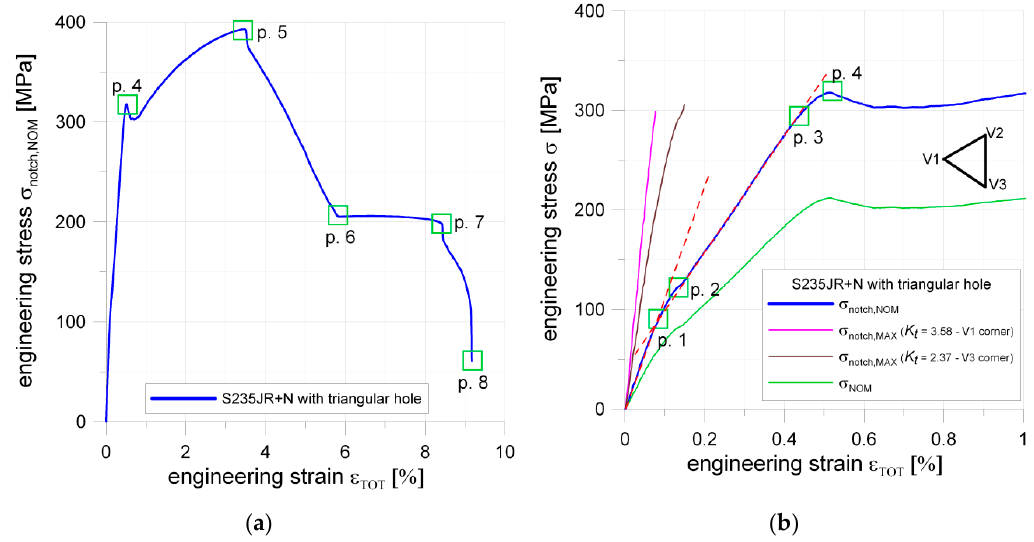
notch,NOM = 380 MPa approximately). The maximum load resulted in maximum stress